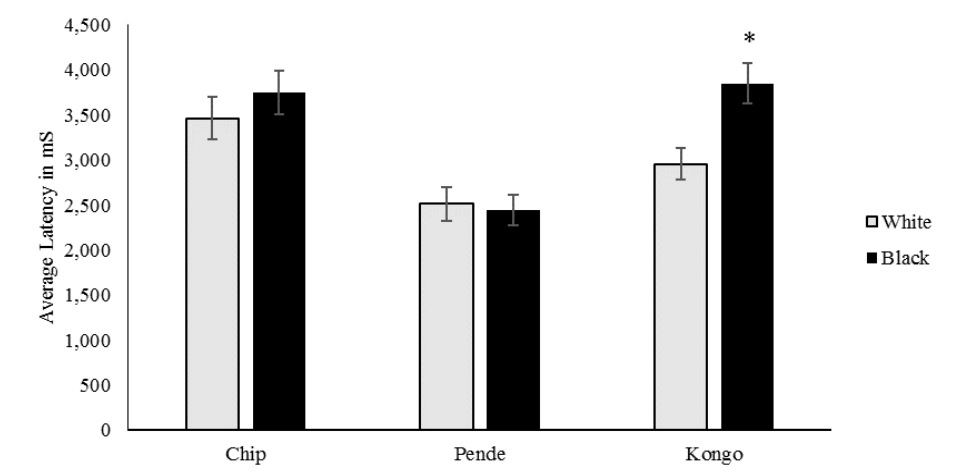
Figure 2 . Average latency to touch the screen comparing black versus white background trials for each subject across the last 100 sessions of training (* p < .05).